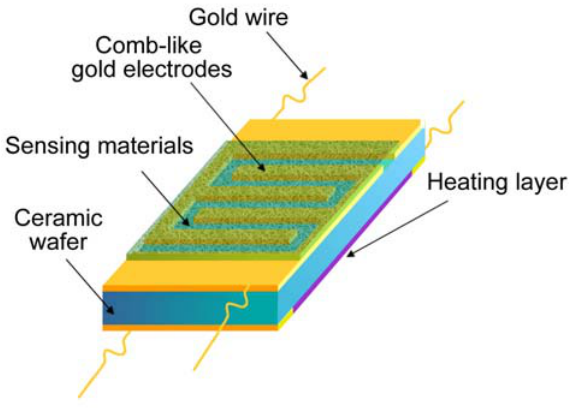
Figure 2. Device structure based on ceramic wafer substrate.